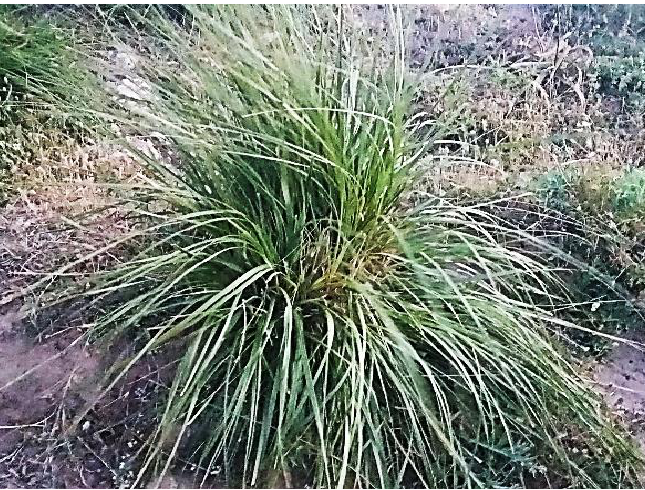
Figure 1. Plant of Diss in Skikda (North-East Algeria).